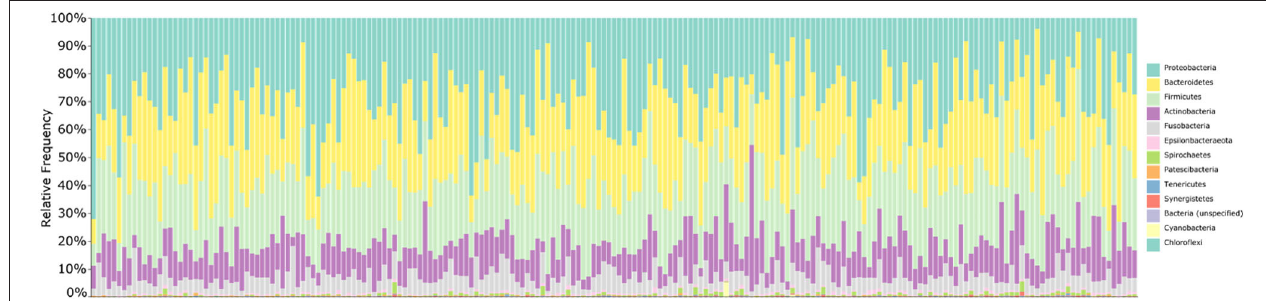
FIGURE 1 | Taxonomic summary of saliva samples. Bar chart summarizing the taxonomic composition of each saliva sample at the phylum level. Bars are ordered by participant age; taxonomy was assigned to 16S V4 amplicon sequences using the SILVA 132 database. Overall, samples are dominated by the phyla Proteobacteria , Bacteroidetes , Firmicutes , Actinobacteria , and Fusobacteria